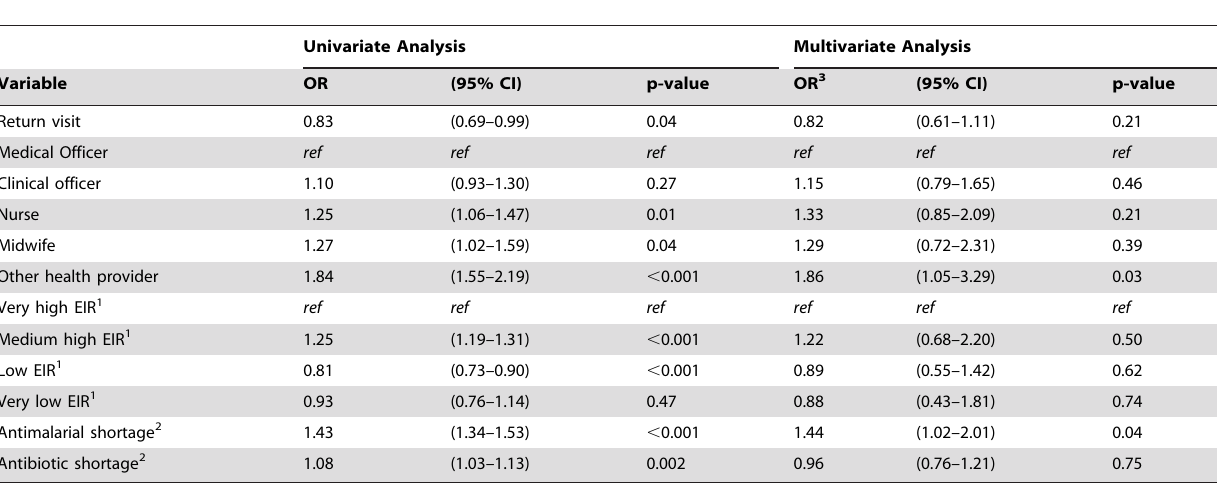
Table 3. Association between operational exposure variables and inappropriate antibiotic treatment in patients without a clinical indication for